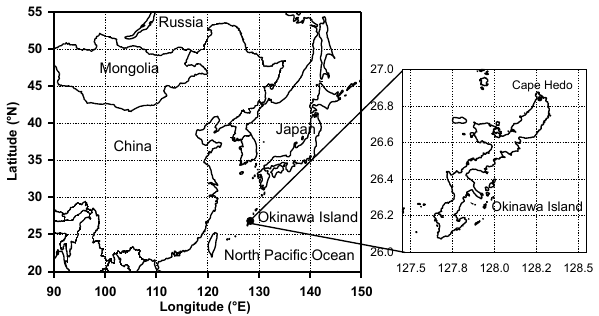
Figure 1. Location of Cape Hedo, Okinawa, East Asia, where total suspended particles were